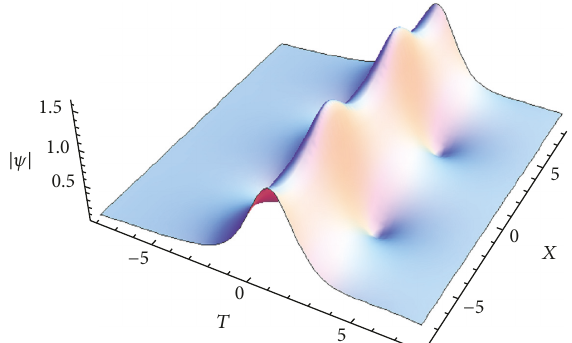
Figure 6: Spatial structure of the module of solution (33).